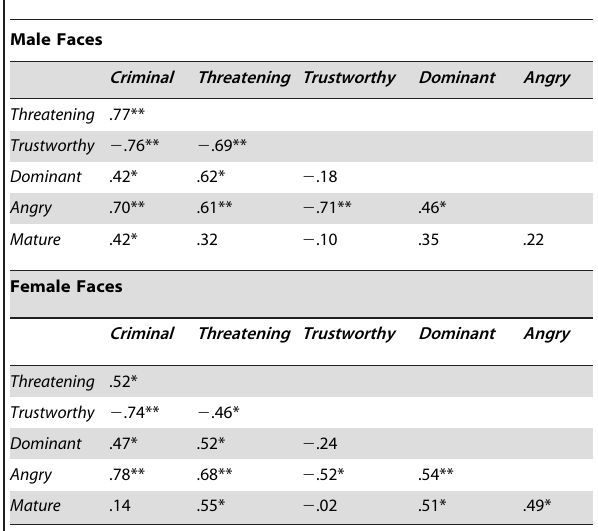
Table 3. Pearson’s Bivariate Correlation Coefficients for Faces in Neutral Pose, Controlled